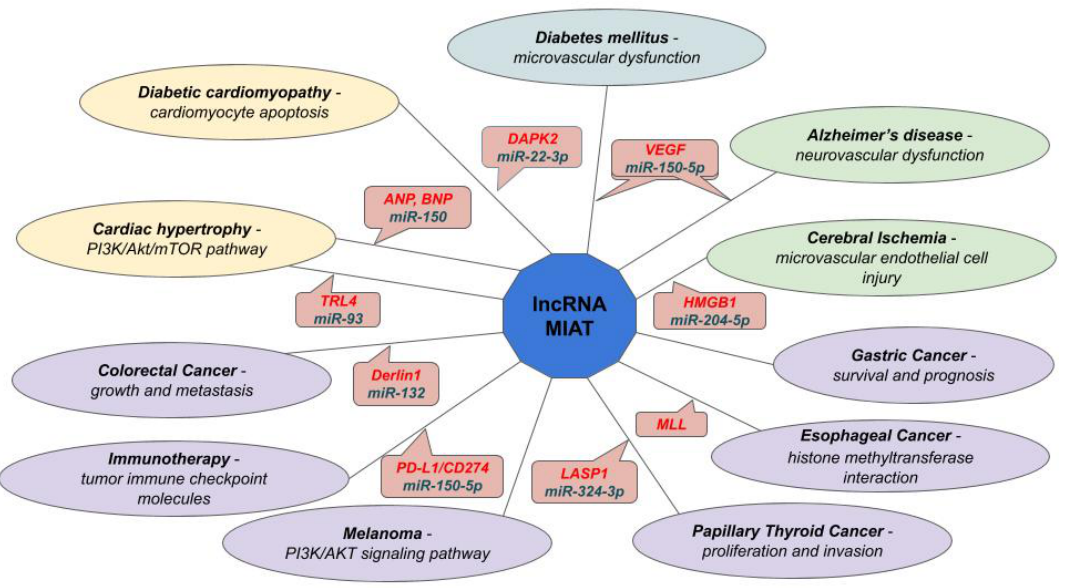
Figure 4. Partial representation of regulatory interaction of lnc-myocardial infarction and associated transcript (MIAT): in ellipses, diseases are reported in bold and dysfunctions in italics; in comics, interacting ceRNAs, or influenced transcripts, are reported in italics red and miRNAs in italics blue. Different colors of ellipses are linked to different types of